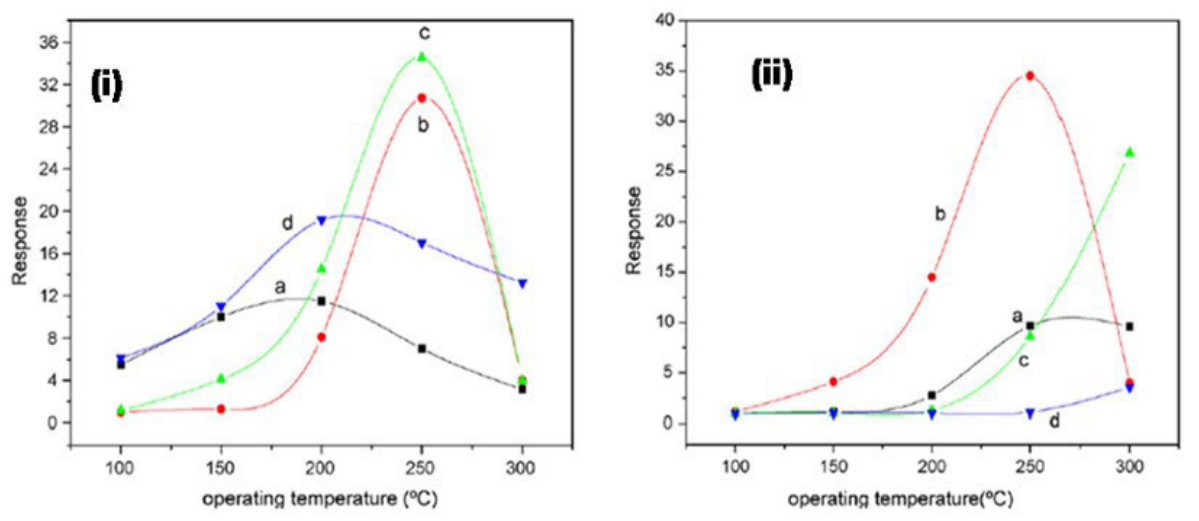
Figure 27. ( i ) The response of different nanocomposites with (a) 0 mol%, (b) 20 mol%, (c) 40 mol% and (d) 60 mol% ZnO calcined at 600 °C to 500 ppm NO 2 ; ( ii ) the response of 40% ZnO–60% SnO 2 nanocomposites calcined at (a) 400 °C, (b) 600 °C, (c) 800 °C and (d) 1000 °C to 500 ppm NO 2 . (Reprinted with permission from [83]. Copyright 2008, Elsevier).